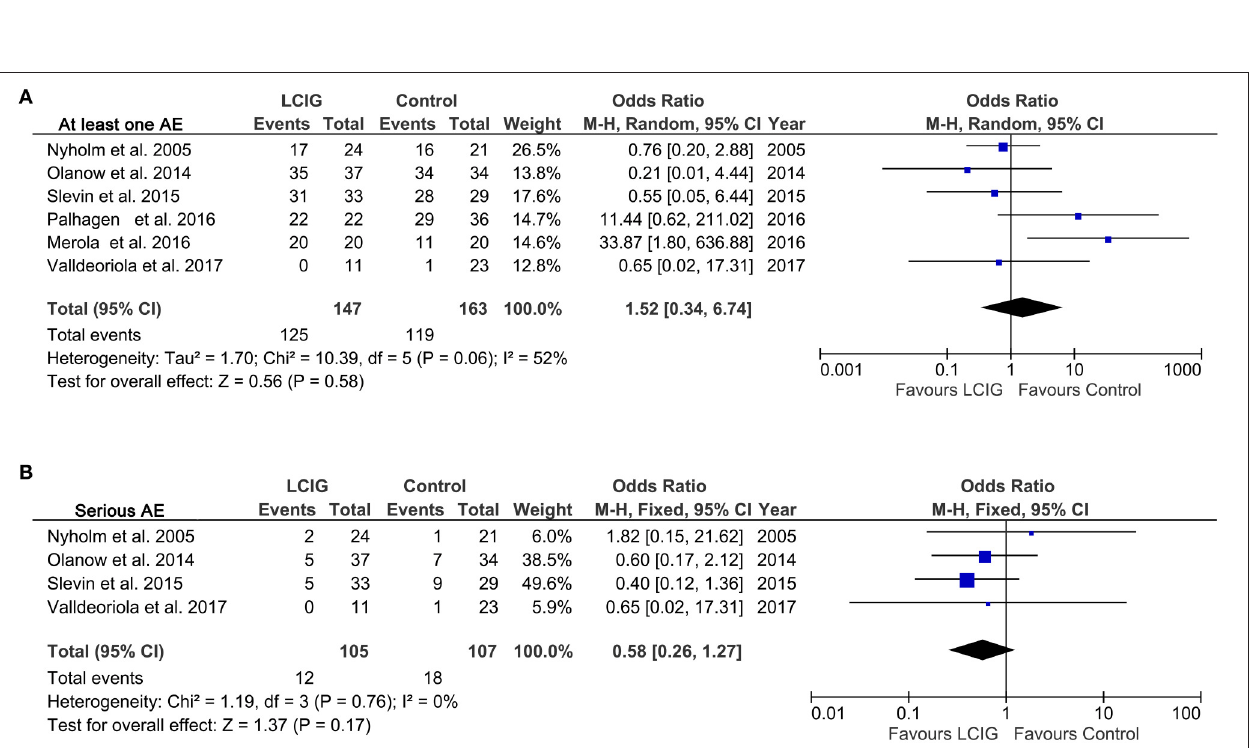
FIGURE 6 | Forest plots of pooled AE in PD patients. Plot A (A) , at least one AE; plot B (B) , serious AE. PD, Parkinson’s disease; LCIG, levodopa-carbidopa intestinal gel; AE, adverse effect.